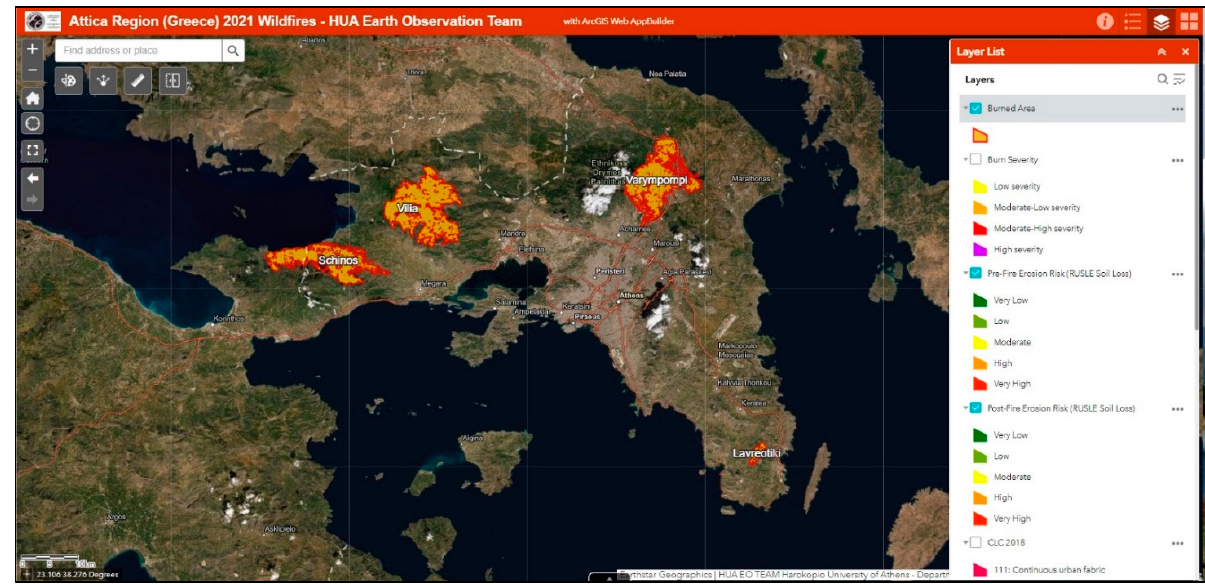
Figure 9. Screenshot of the developed web app. The user interface is shown with the web map of the affected areas and the widgets.